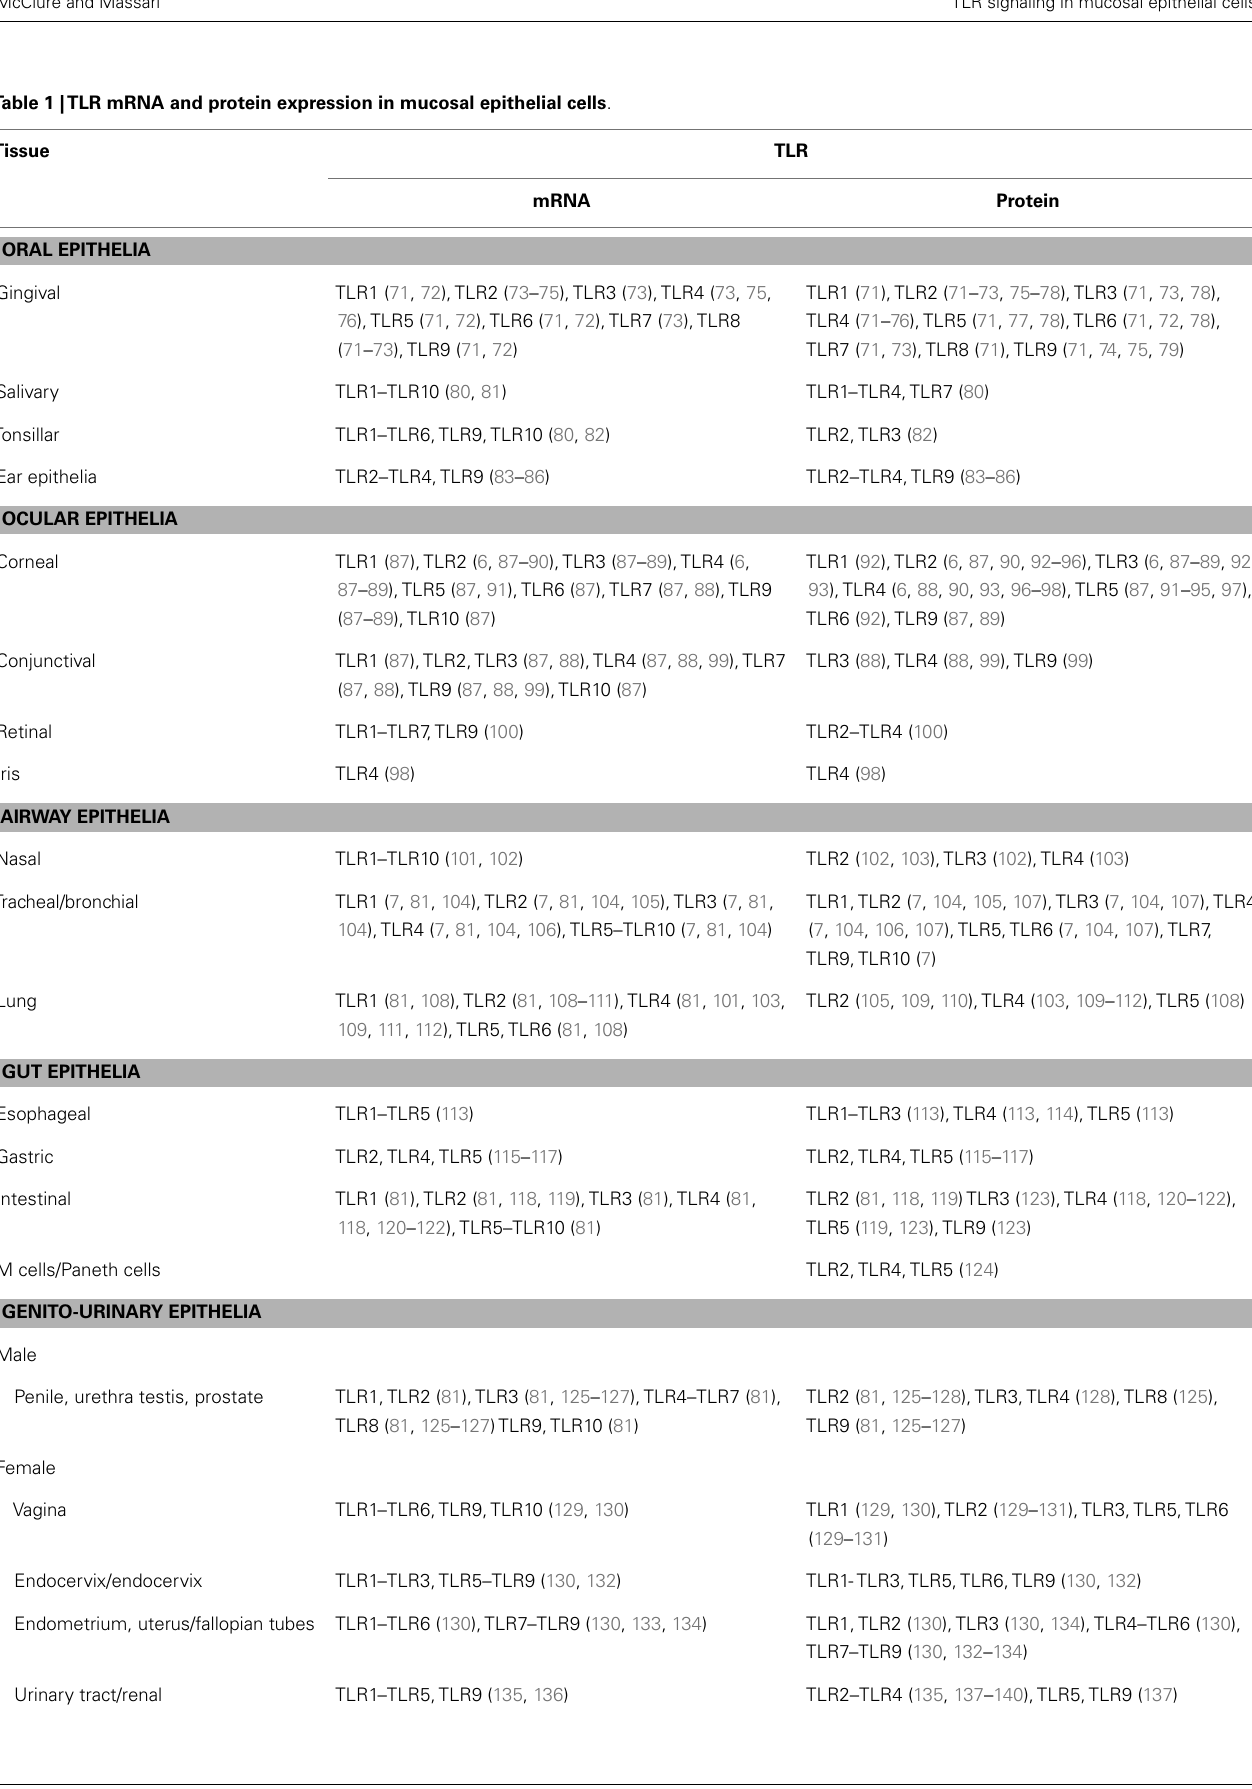
Table 1 |TLR mRNA and protein expression in mucosal epithelial cells